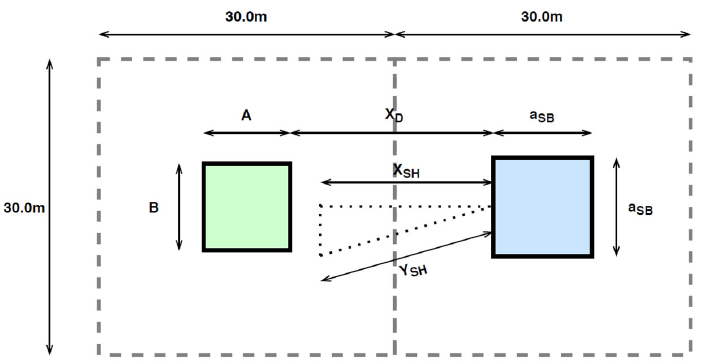
Figure 3. Schema of shading assumption method used in the solar module in the TEAC